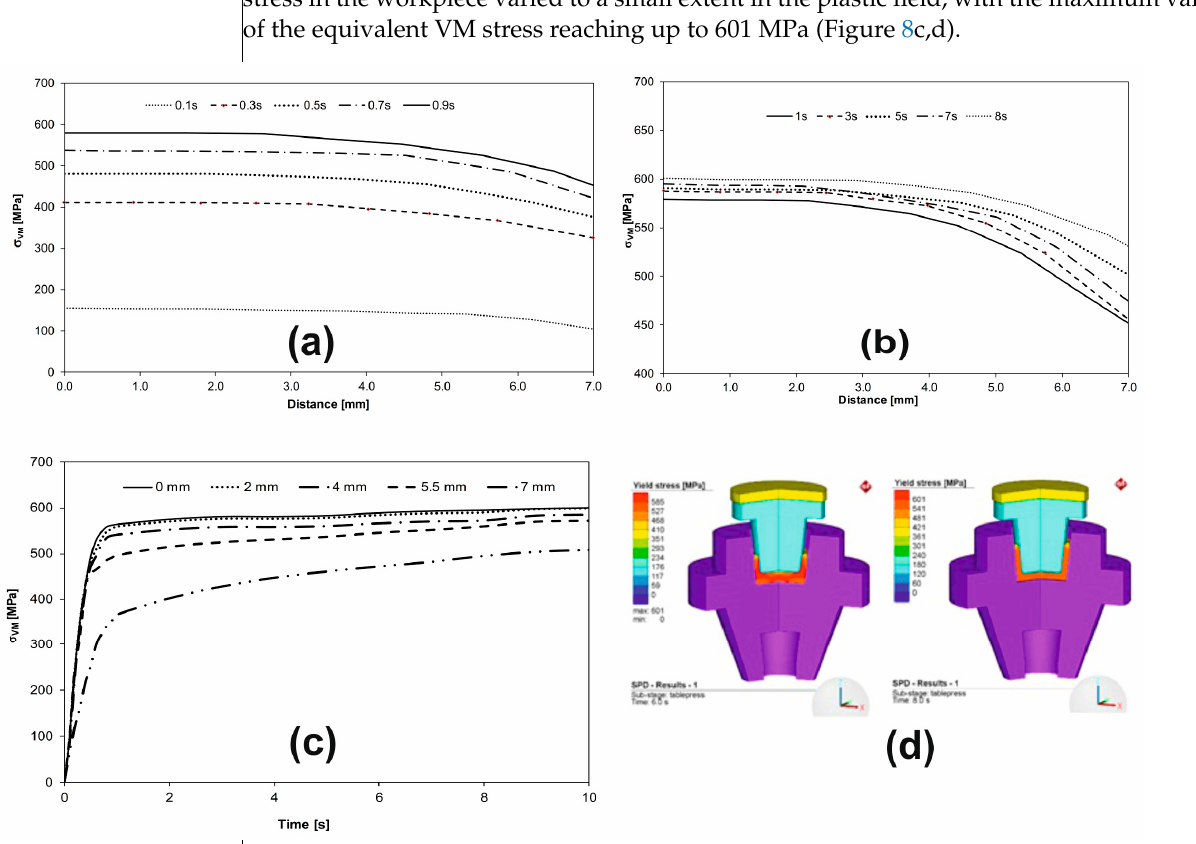
Figure 8. Von Mises stress distribution: ( a ) on the upper surface of the workpiece at the time interval between 0 and 1 s, ( b ) on the upper surface of the workpiece between 1 s and 8 s of the HSHPT process, ( c ) Von Mises stress versus time in the points located on the upper surface of the workpiece, ( d ) Von Mises stresses at two moments of time, 6 s and 8 s.